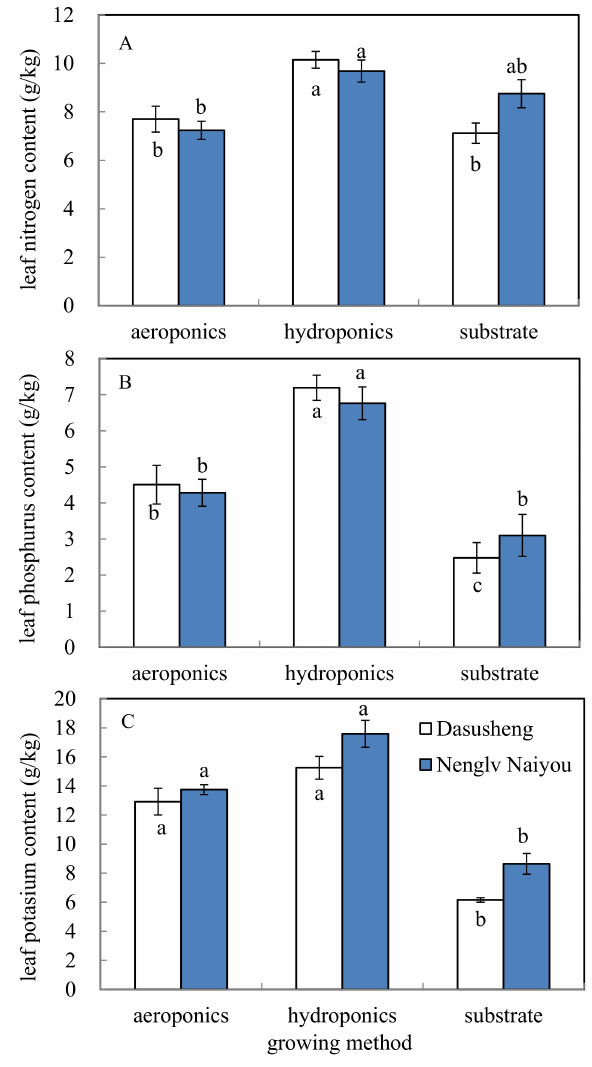
Figure 3. Leaf nitrogen ( A ), phosphorus ( B ), and potassium ( C ) content of two lettuce cultivars grown on aeroponics, hydroponics, and substrate cultivation systems. Values are mean ± SE ( n = 3). In the same cultivar, values followed by the same letter are not significantly different ( P ≤